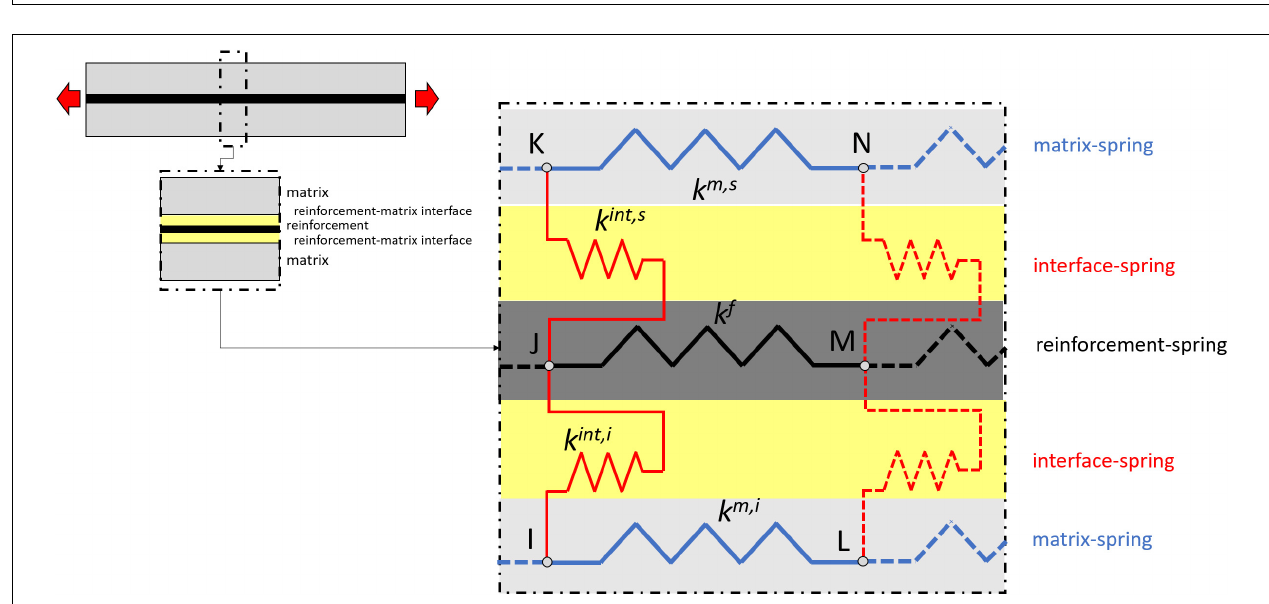
FIGURE 2 | Clevis setup configuration: (A) setup scheme; (B) scheme accounted for the modeling phase.